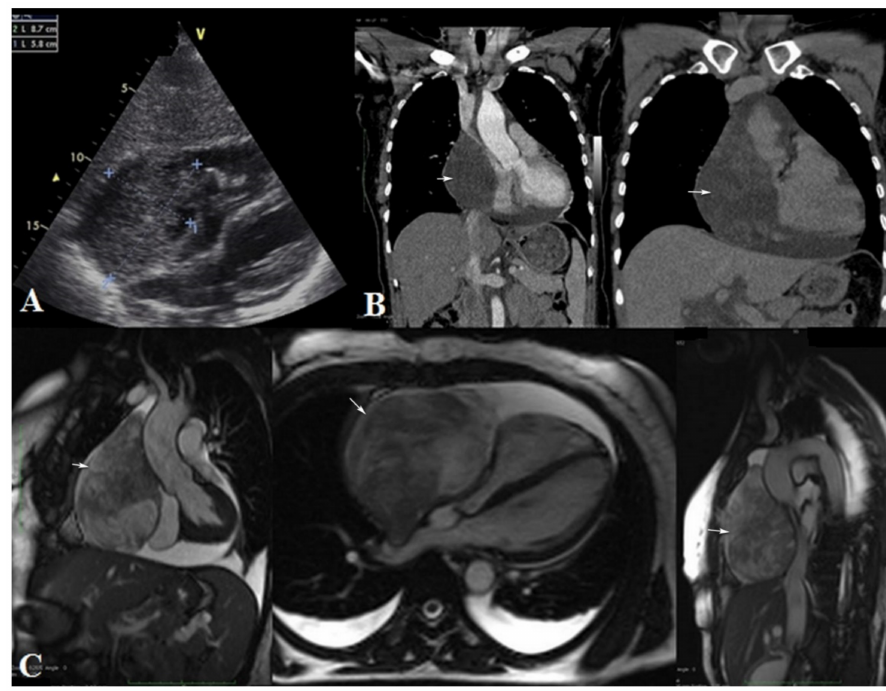
Figure 1. ( A ): Echocardiography; ( B ): computer tomography with contrast enhancement—coronal plane; ( C ): MRI—coronal, axial and sagittal T2 WI; There is a large, inhomogeneous, enhancing intrapericardial mass, surrounded by fluid, with marked compressive effect on the superior vena cava and right heart cavities (arrows). No intracavitary or endoluminal invasive aspects are present. On echocardiography and dynamic sequence MRI (cine sequences), the interventric- ular septum displayed a paradoxical motion with the right atrium and ventricle being collapsed and dyskinetic. All the above-mentioned characteristics represented indirect signs of cardiac